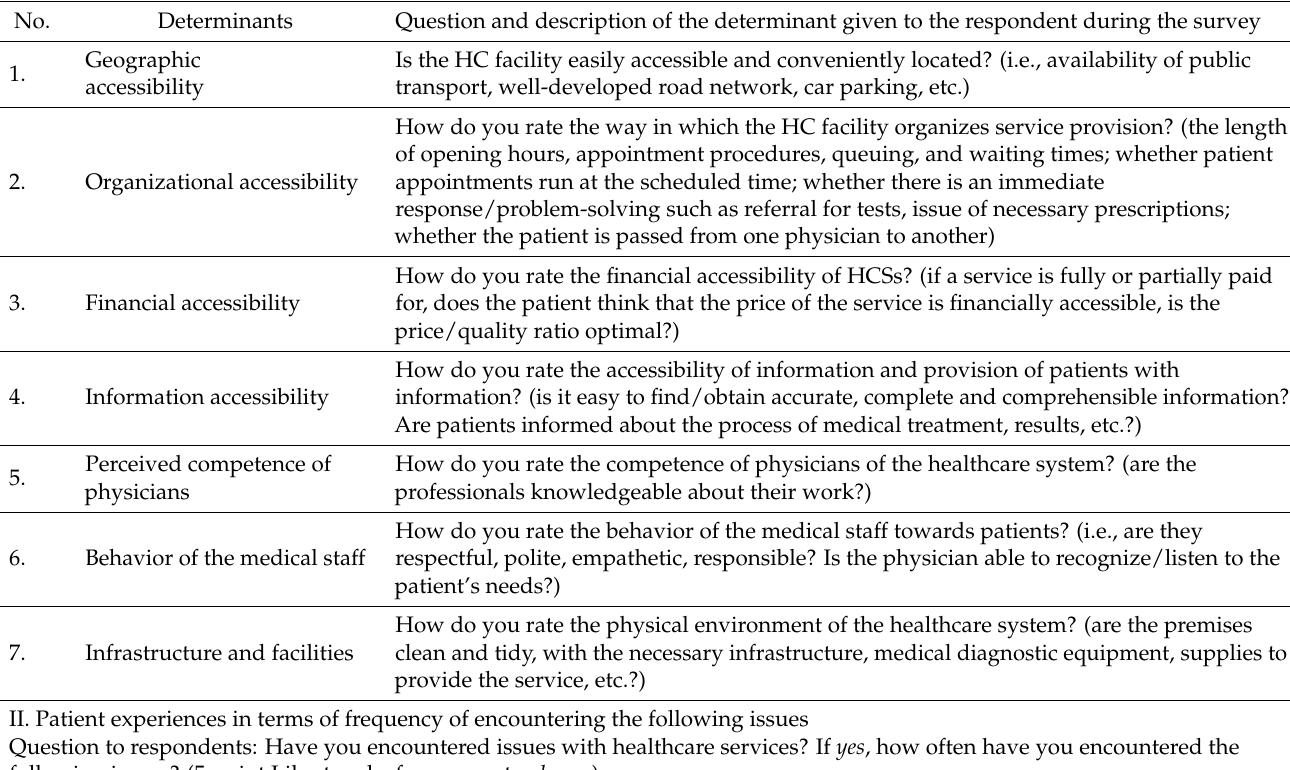
Table A1. Determinants of the overall assessment of PPHQ in primary healthcare, as selected during the